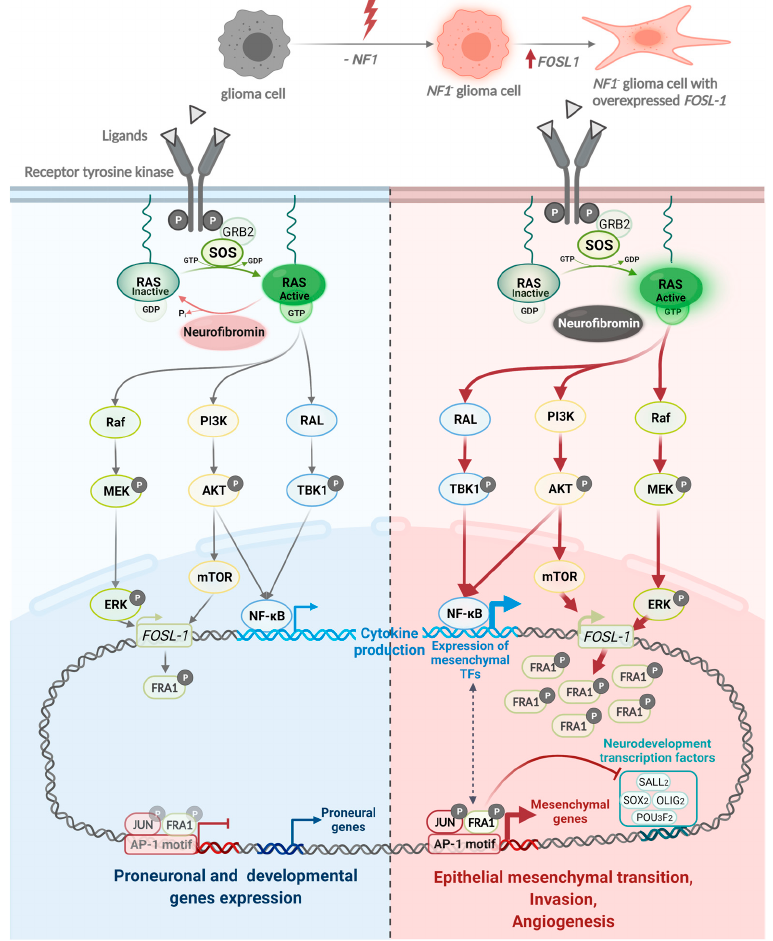
Figure 6. FOSL1 is regulated by neurofibromin and its role for proneural to mesenchymal transition. Created with BioRender.com (SY2390LZAW, 27 November 2021).